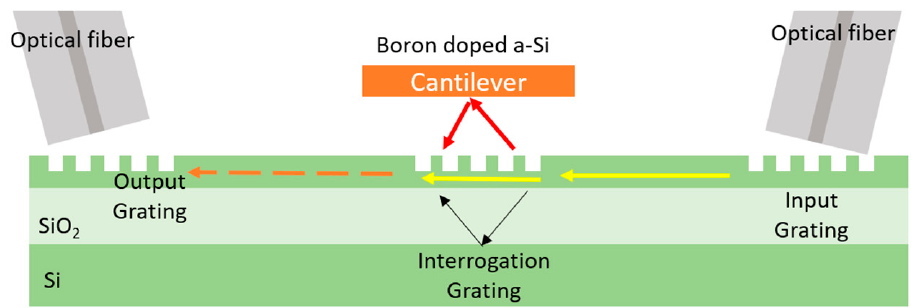
Figure 8. Schematic of an SOI-based vibrometer measuring a cantilever on top of the sensor